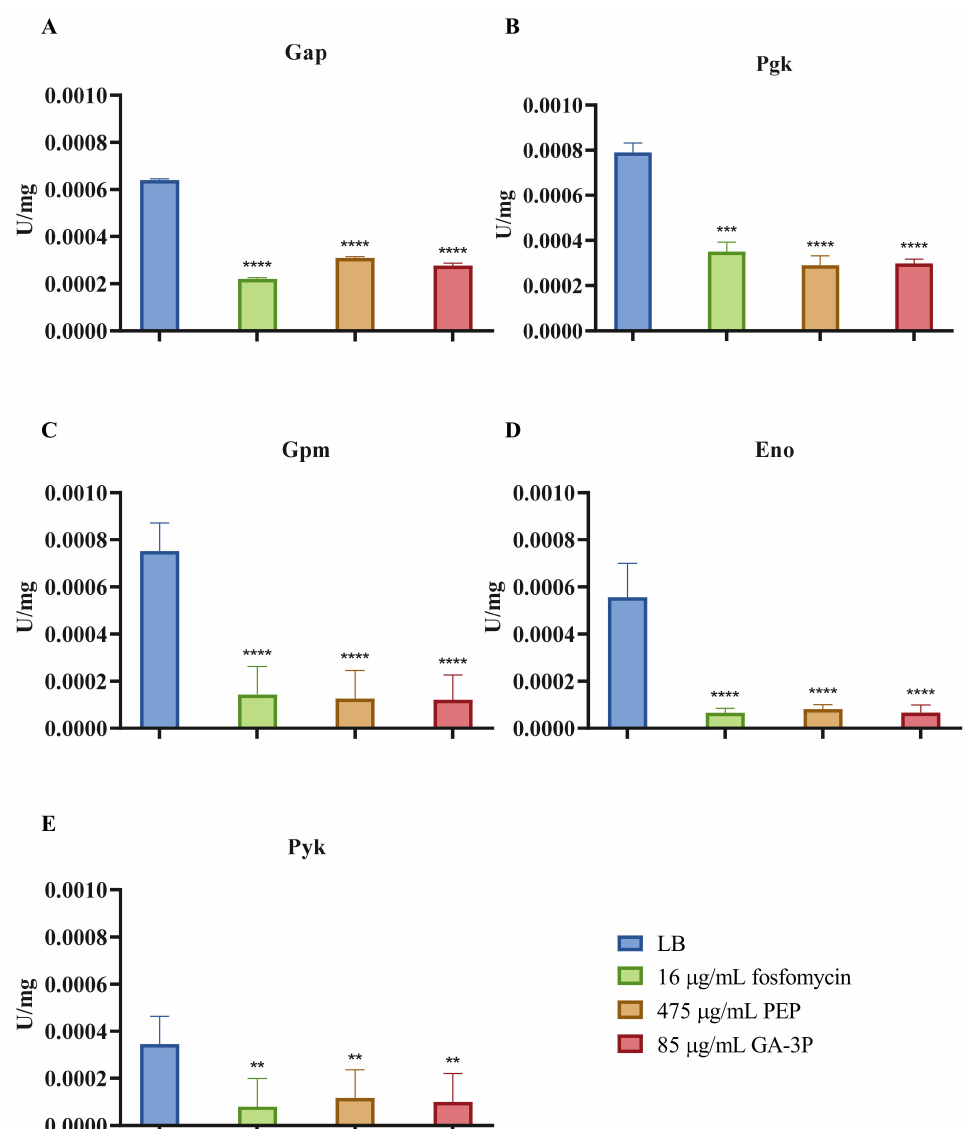
Figure 7. Enzymatic activity of the enzymes from the lower glycolytic pathway of the D457 strain in the exponential growth phase without treatment, or after 1 h of fosfomycin, PEP, or GA-3P treatment: ( A ) Gap glyceraldehyde-3-phosphate dehydrogenase activity; ( B ) Pgk phosphoglycerate kinase activity; ( C ) Gpm phosphoglycerate mutase activity; ( D ) Eno enolase activity; ( E ) Pyk pyruvate kinase activity. Error bars indicate standard deviations for the results from three independent replicates. As shown, both treatments impaired the activity of all of the lower glycolytic enzymes. Values that are significantly different from the values for the samples without treatments were calculated by an unpaired two-tailed t -test, and are indicated by asterisks as follows: **: p < 0.004; ***: p < 0.0007; ****: p <